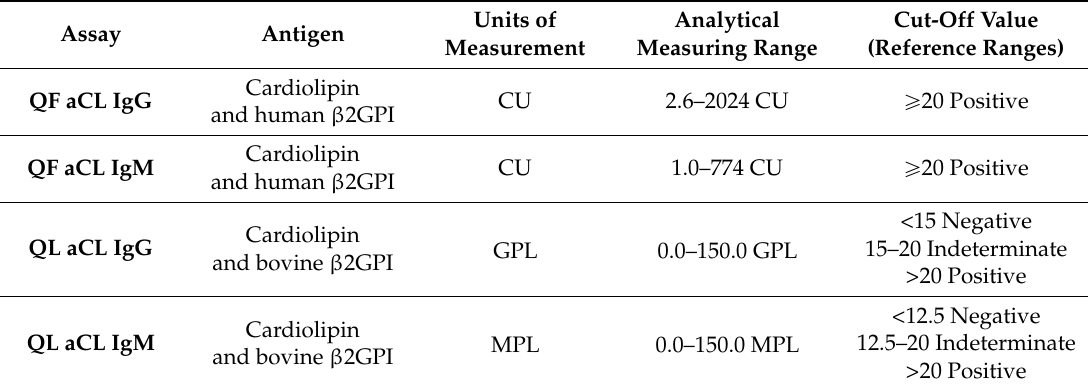
Table 3. Analytical characteristics of the aCL antibody assays used in this study. Assay Antigen